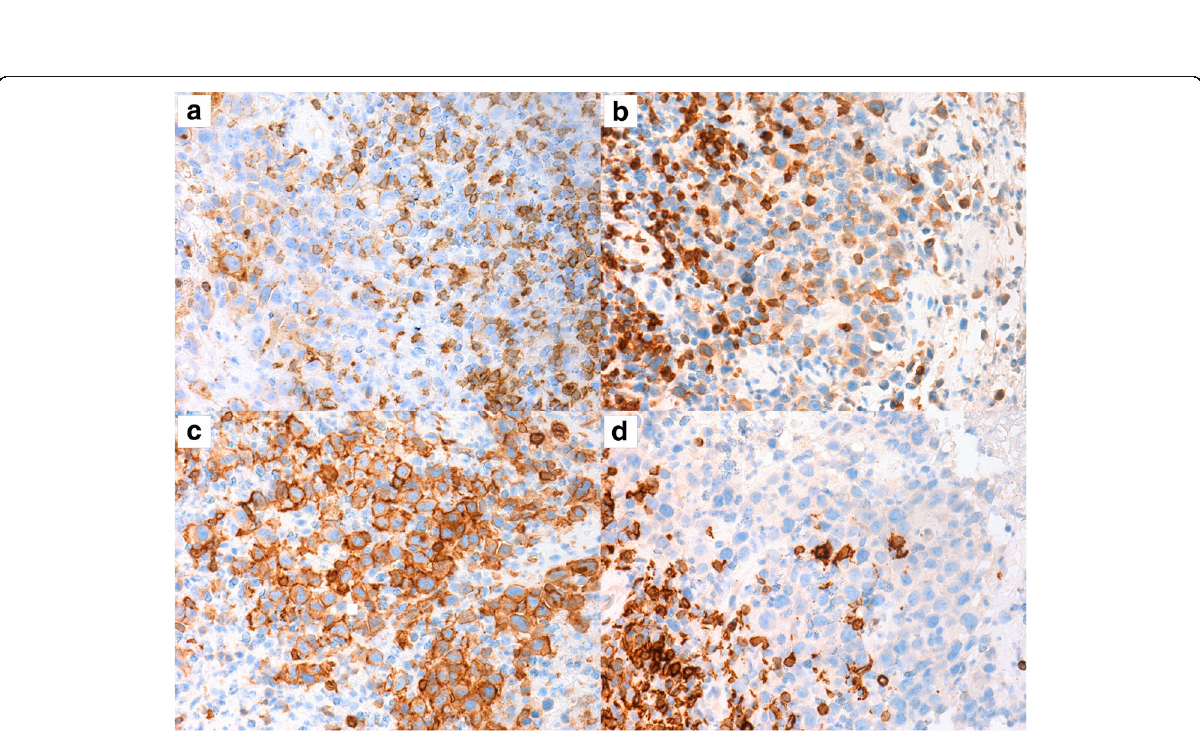
Fig. 3 Immunohistochemical panel performed on the biopsy material. The large neoplastic cells showed varied degrees of positivity for CD2 ( a ), CD3 ( b ), CD5 ( c ), and CD7 ( d ) (400×). Notice that small reactive lymphocytes function as positive control. The marker with the highest number of positive neoplastic cells was CD5, whereas that with the highest deletion was